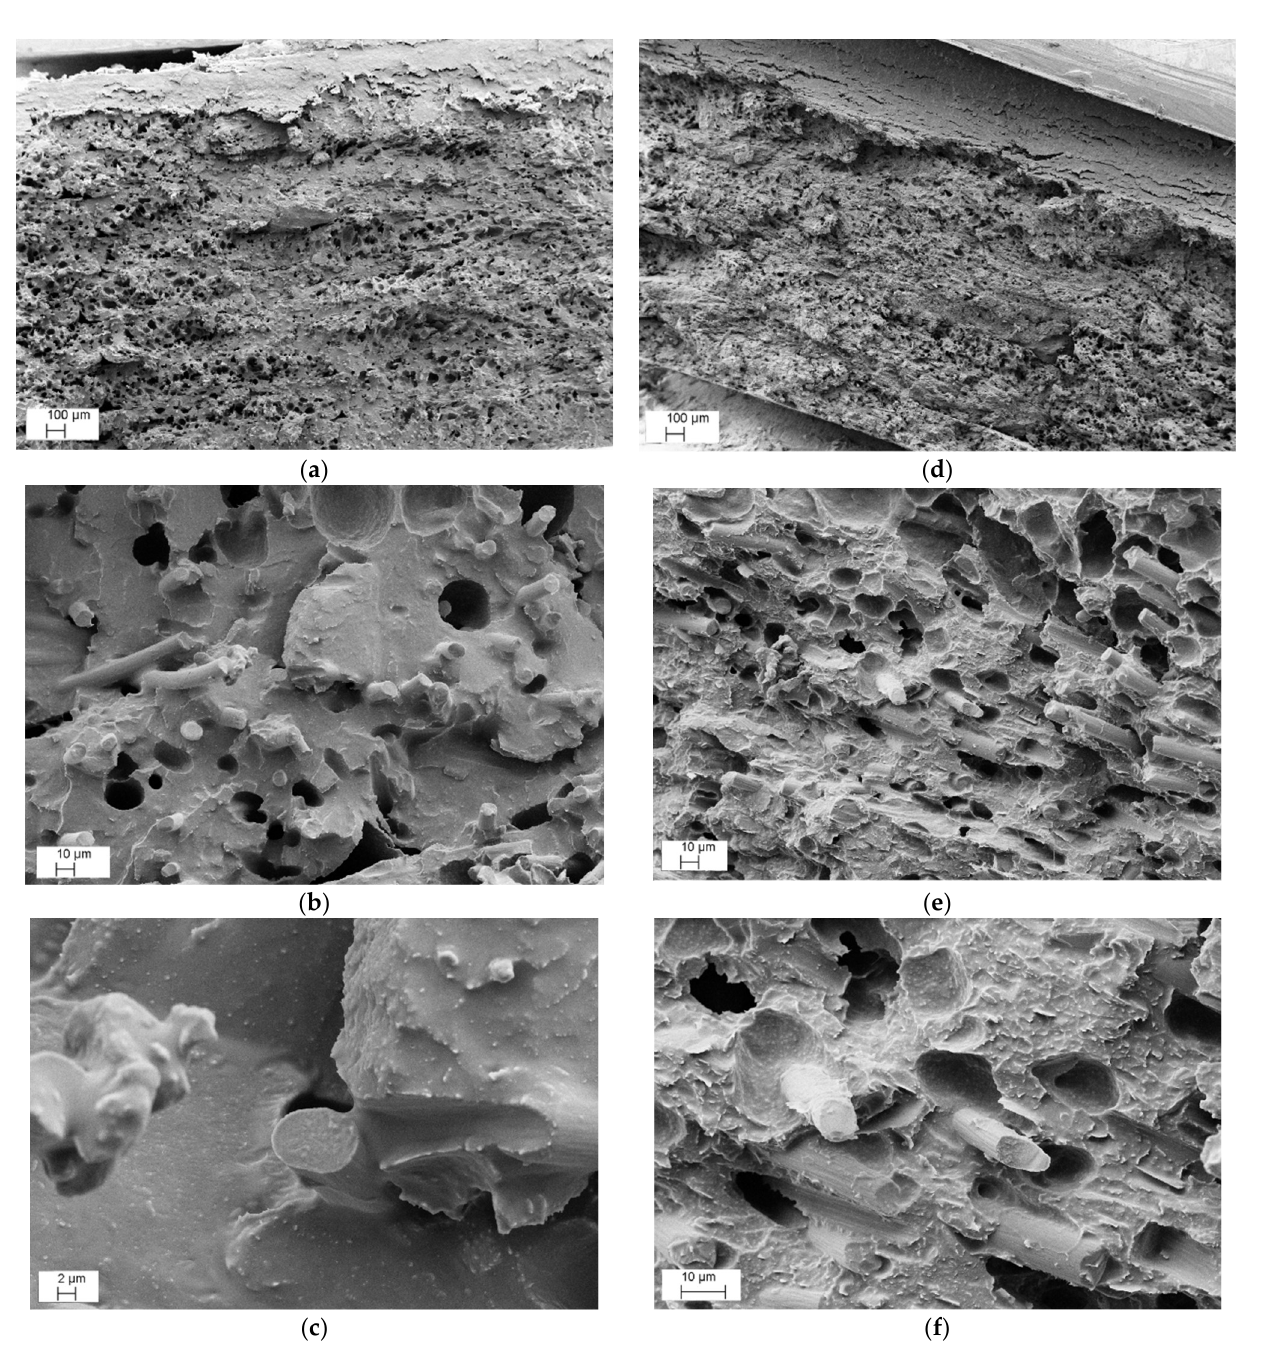
Figure 11. Representative FESEM micrographs at various magnifications of fracture surface of 3D_MCF20-CNT3 ( a – c ) and 3D_MCF20-GNP6 ( d – f ) composite samples.